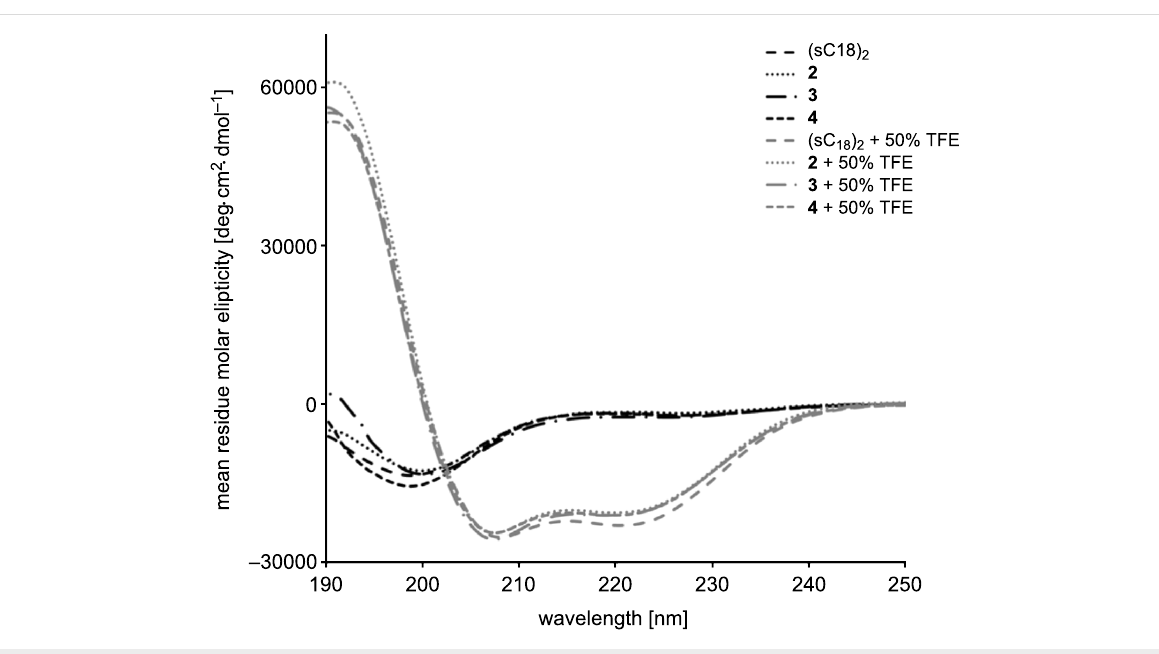
The bioconjugates were tested for cytotoxicity in MCF-7 and HT-29 in the presence of serum by using a resazurin-based cell viability assay. These are well-established tumor cell lines that allow for direct comparison of the results with previous studies. All substances were shown to exhibit significant cytotoxicity in both cell lines (Figure 7). IC 50 values are given in Table